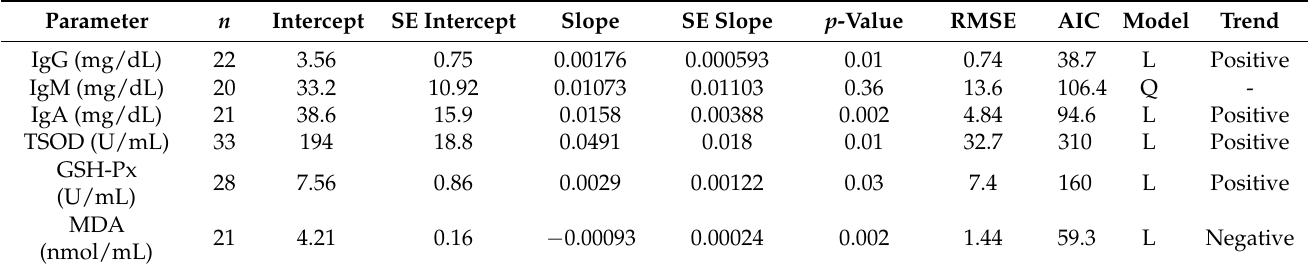
Table 5. Regression equations for the impact of phytogenic extract levels on immunological and antioxidant parameters of laying